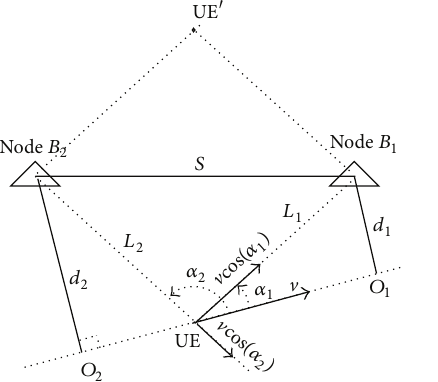
Figure 2: Relationship between direction angle and frequency shift in the moving process.